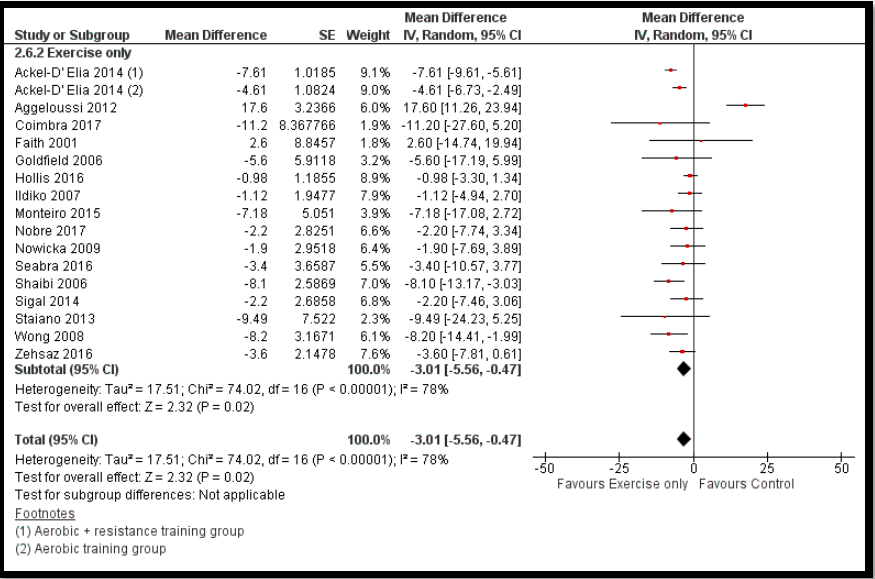
Figure 10. Forest plot for the e ff ect of exercise only interventions for obesity management on body weight .